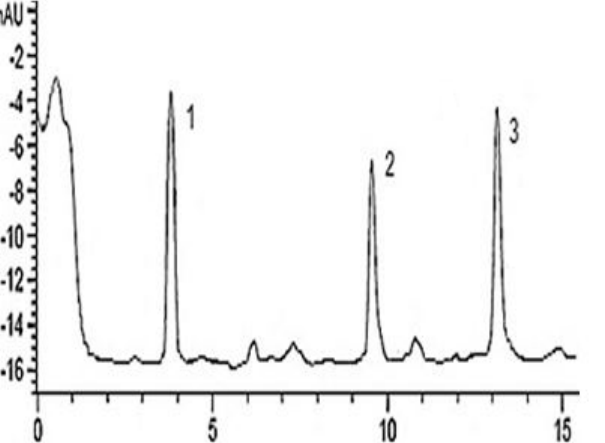
Figure 7. HPLC analysis of phenolic compounds extracted using SC-CO 2 with 80% ( v / v ) ethanol- water as a co-solvent, at 40 °C and 250 bar from leaves of L. pumila : (1) gallic acid, (2) methyl gallate, and (3) caffeic acid.